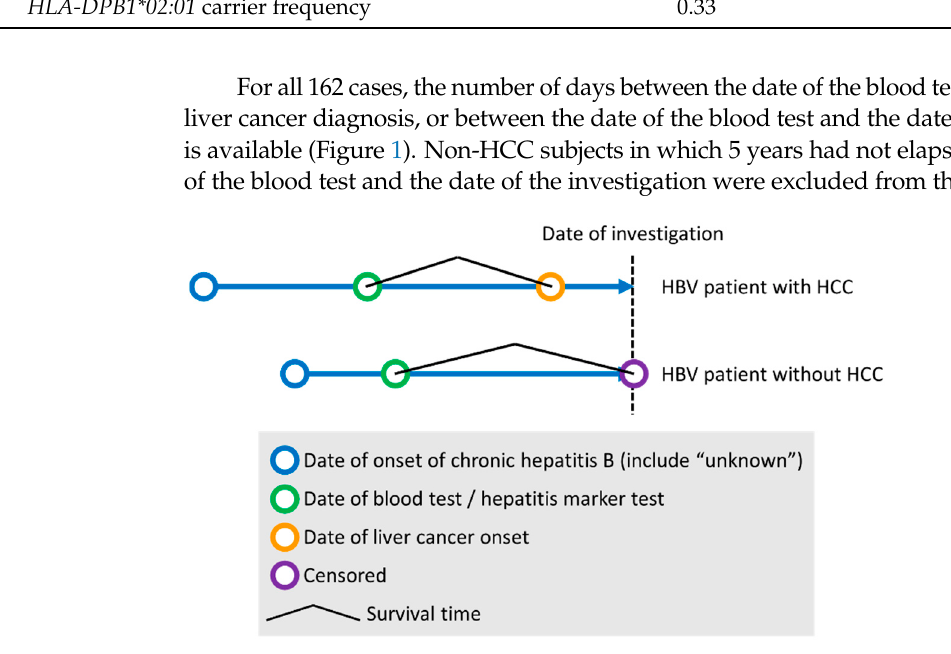
Figure 1. Study design for Cox proportional hazards regression analysis.